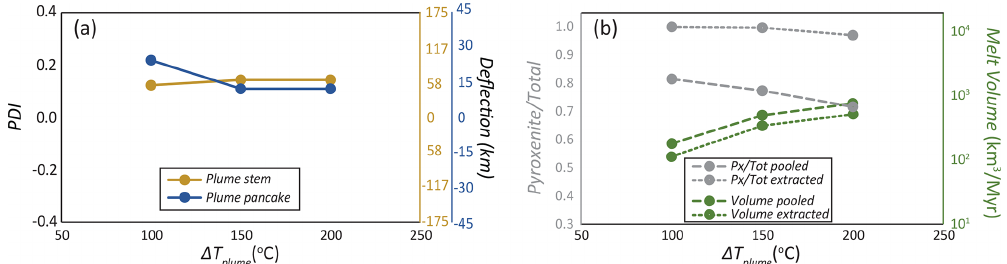
Figure 4. Diagrams showing the sensitivity of several output parameters as a function of (cid:49)T plume . (a) Plume distortion index (PDI) for the different models (see text for explanation). Note that all values are positive (deflection away from the edge). (b) Melt volumes fluxes ( M and V ) and melt compositional index ( M PX and V PX ) for the different models. Predictions in terms of melt production ( M , M PX M V dashed lines; predictions in terms of melt extraction ( V , V PX ) as dotted lines. V